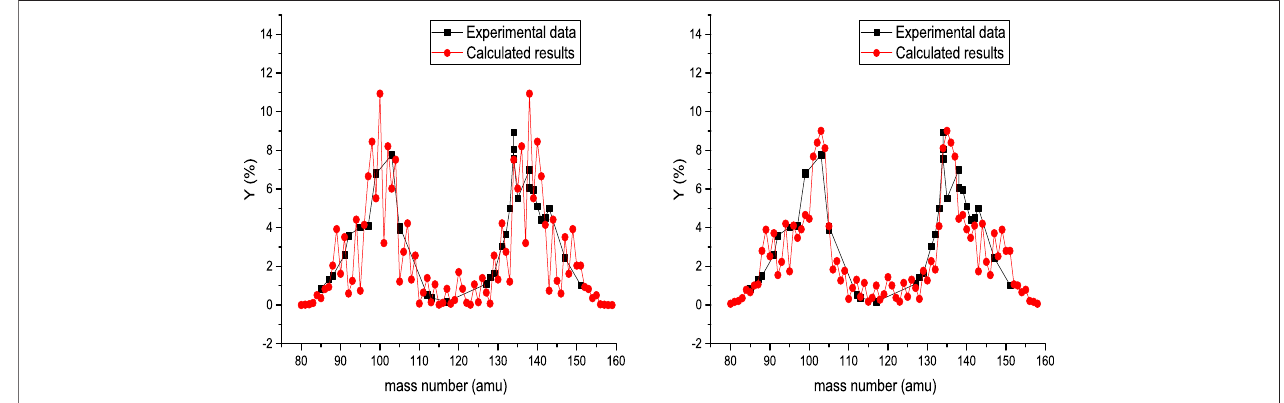
FIGURE 4 | Calculated mass yield for photo fi ssion of 240 Pu at 10 MeV bremsstrahlung endpoint energy, accompanied by experimental data [39]. In the left and right sides are presented the calculated results obtained for T coll (cid:1) 1 MeV and T coll (cid:1) 2 MeV, respectively.